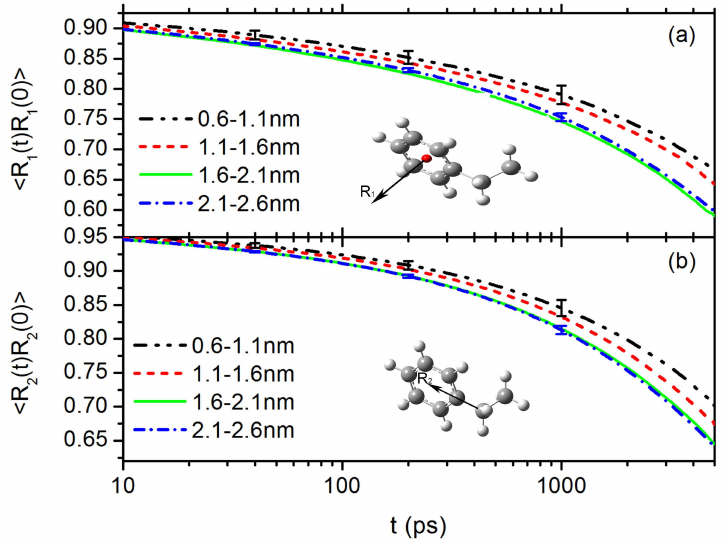
Figure 3. Time auto-correlation function of: ( a ) the normal vector of the surrounding phenyl rings; and ( b ) the carbon bond connecting phenyl ring and the PS chain backbone.